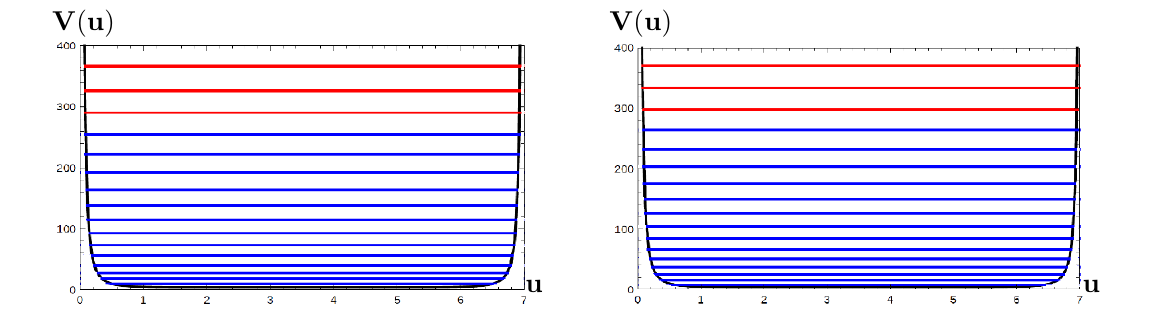
Figure 8. Plot of di(cid:11)erent roots in the poten- tial V ( u ) for n = 3 spikes. The top three levels which we have used in our calculations, start- ing from top have h = 370 : 74 (red), h = 333 : 23 (red) & h = 297 : 87 (red)